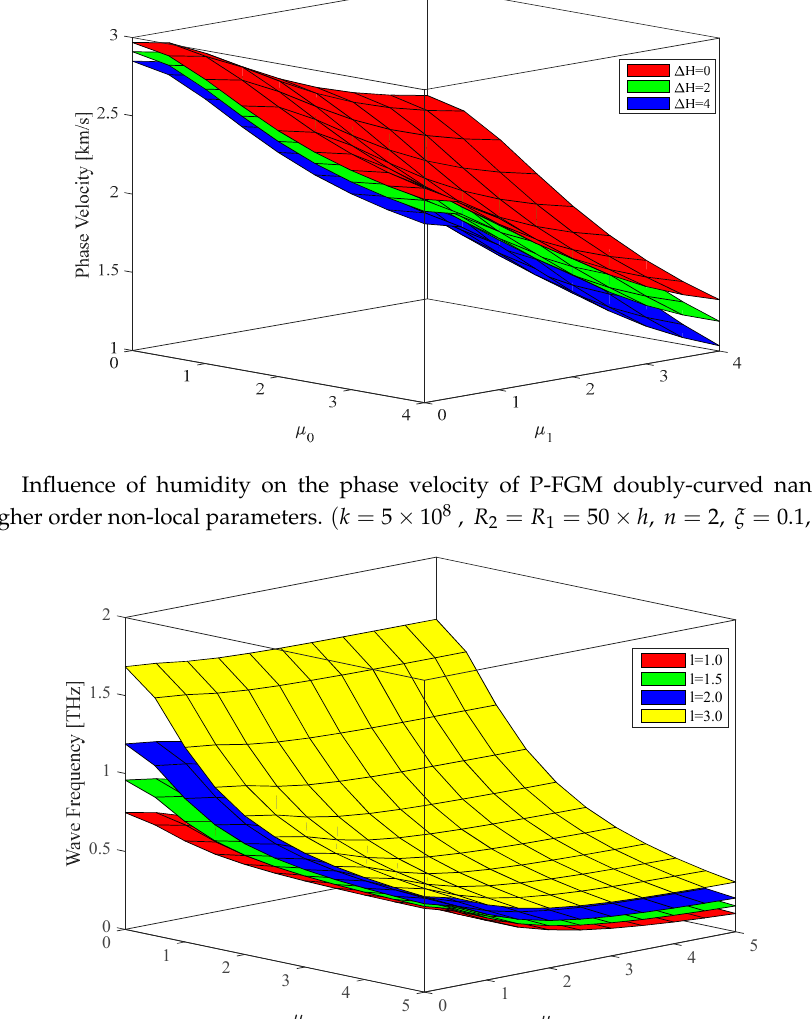
Figure 7. Influence of temperature on the phase velocity of P-FGM doubly-curved nanoshell vs. lower/higher order non-local parameters. ( k = 5 × 10 8 , R 2 = R 1 = 50 × h , n = 2, ξ = 0.1, λ = 2 ) .